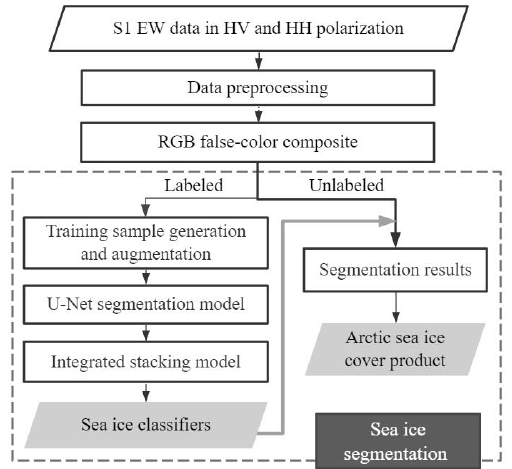
Figure 2. Flowchart of the proposed method for deriving sea ice cover information from S1 EW images in HV and HH